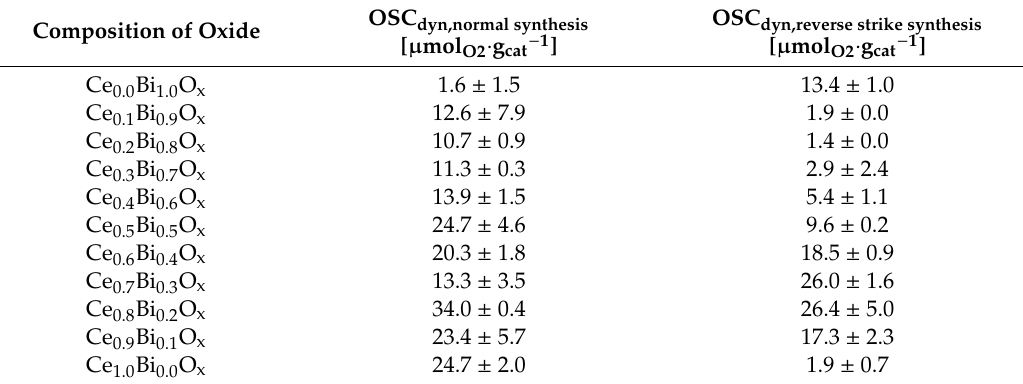
Table 4. Calculated dynamic oxygen storage capacity (OSC dy n) of the synthesized mixed oxides determined by thermogravimetric analysis (TGA). Measurement temperature in the range of T = 150–700 ◦ C with heating rate of r = 5 ◦ C · min − 1 in synthetic air and nitrogen. The average of double determination with the standard deviation is